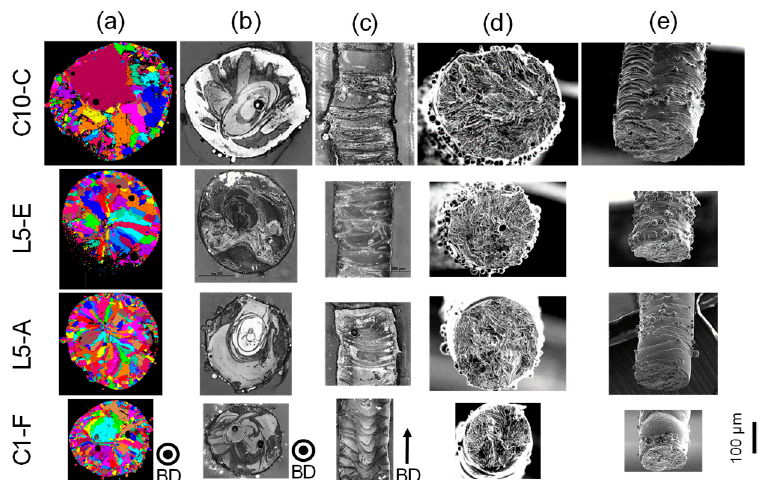
Figure 7. Overview of selected strut specimens and their corresponding microstructural (SEM images; building direction—BD—is highlighted; ( a ) EBSD grain map, ( b ) etched perpendicular section and ( c ) etched longitudinal section) and fracture surface fingerprints (SEM images; ( d ) fracture surface and ( e ) tilted fracture surface).